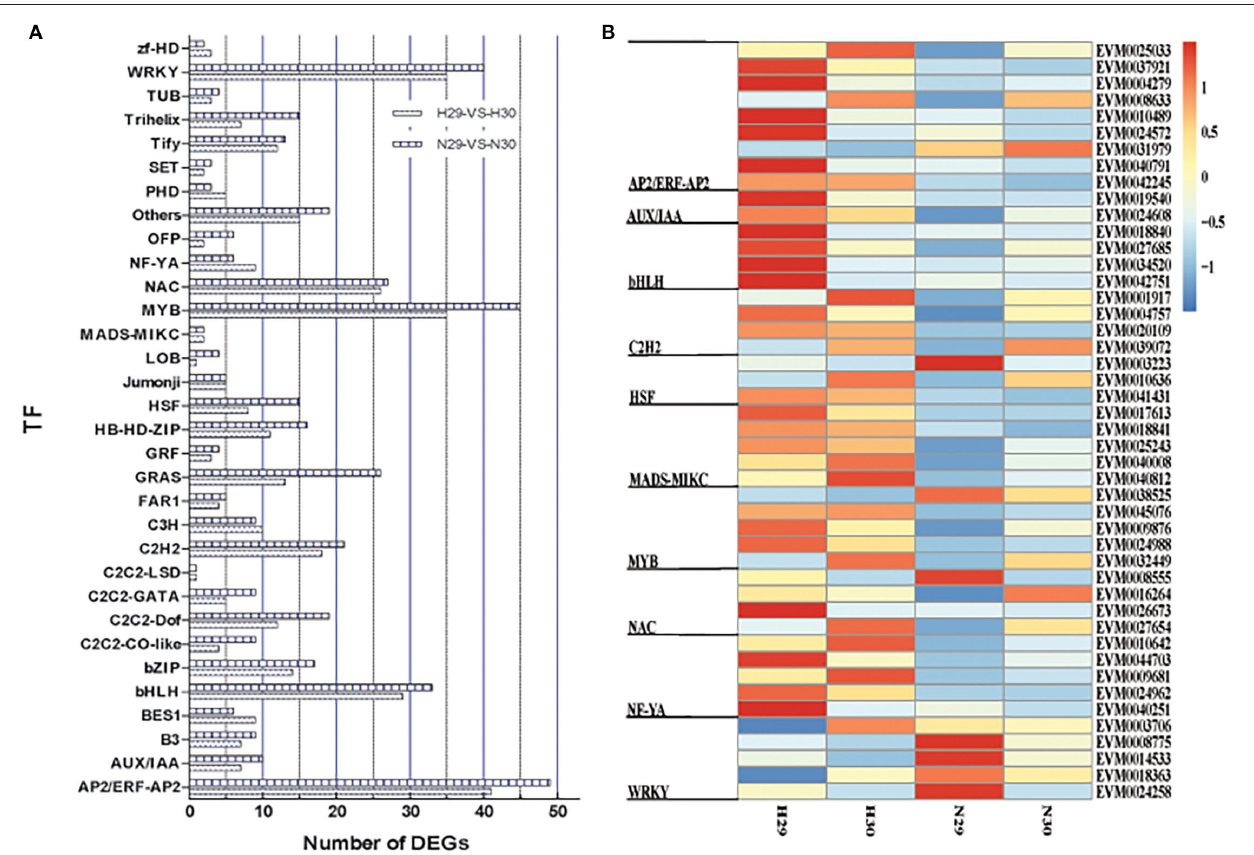
FIGURE 6 | Distribution and expression profile of differentially expressed transcription factors (DETFs) under cold stress both in two loquat varieties. (A) The distribution of TFs; (B) the expression profile of TFs.